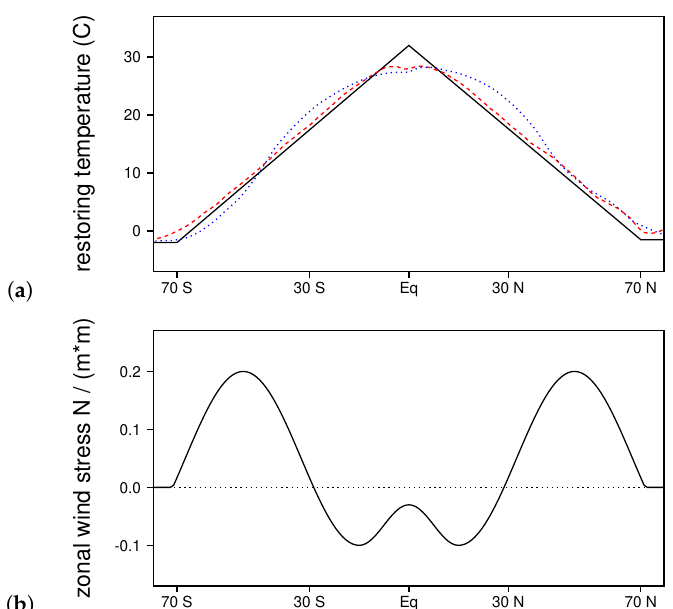
Figure 5. Surface forcing. ( a ) restoring temperature (solid black line), average SST in the simulation with mixing (red dotted line), and observed average SST (blue dotted line), which is from the NCEP Optimally Interpolated weekly SST and Sea Ice datasets for the years 1998–2009. ( b ) zonal wind